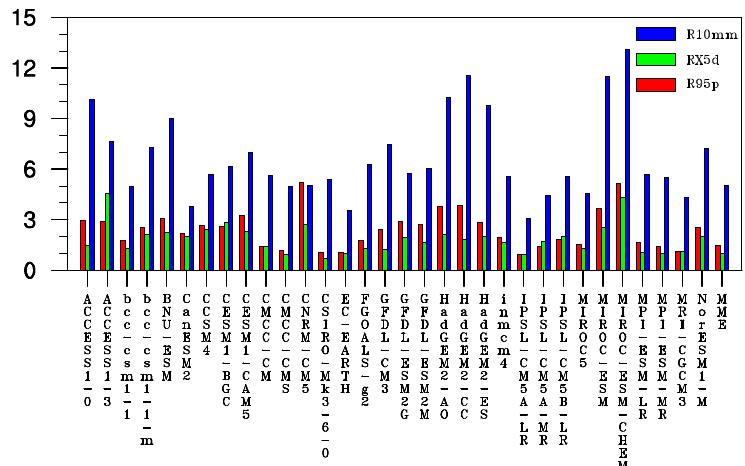
Figure 4. IVS of 32 individual CMIP5 climate model and CMIP5 multi-model ensemble mean for three extreme rainfall indices including R95p (red), RX5d (green), and R10mm (blue).